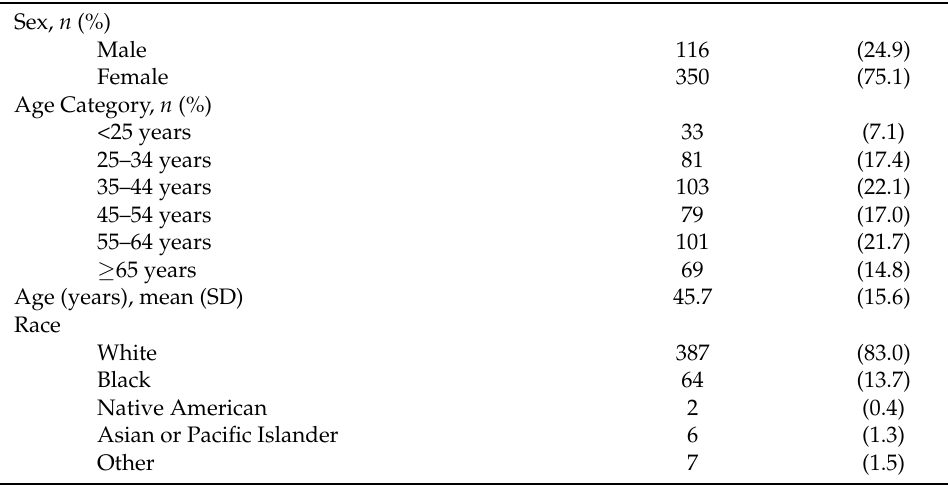
Table 2. Characteristics of participants who completed the Alcohol Consumption Assessment Preference Survey (N =